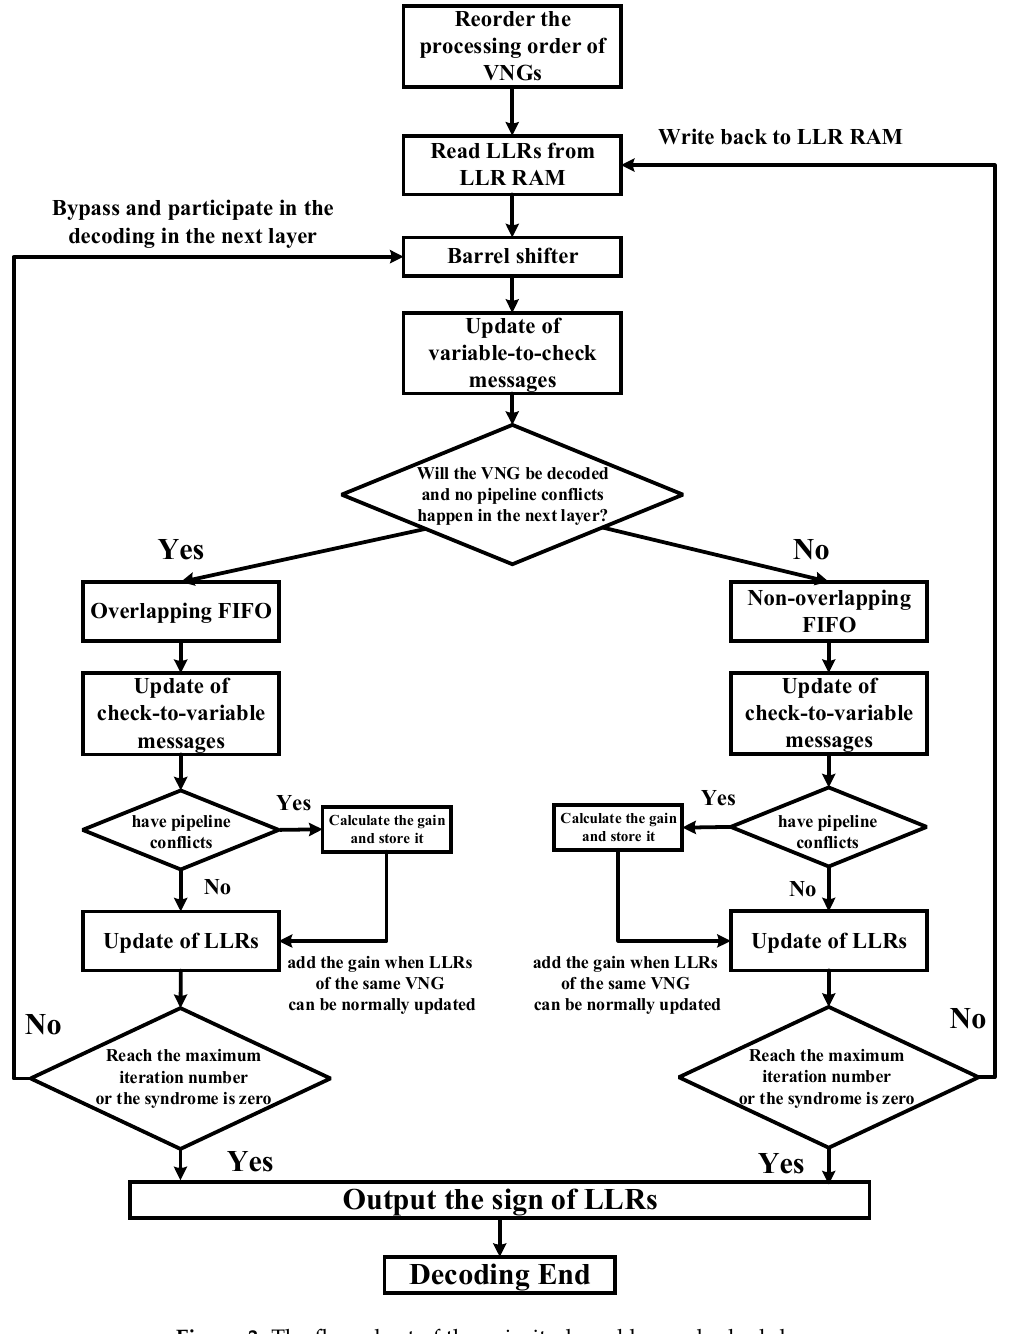
Figure 3. The flow chart of the priority-based layered schedule. In our design, variable nodes in a layer are processed in units of submatrix. For sim- plicity of presentation, the variable nodes in a submatrix are denoted as variable node group (VNG). Before decoding, the processing order of VNGs in a layer needs to be reor- dered. In a layer, the VNGs that have not been decoded in the previous layer are decoded first. Next are the VNGs that have been decoded in the previous layer. When the processing order of VNGs is determined, decoding starts. LLRs are suc- cessively read out from LLR RAM. After the processing of barrel shifter and VNU, varia- ble-to-check messages are obtained. According to the mechanism of double update queues, variable-to-check messages are buffered into overlapping FIFO or non-overlap- ping FIFO. Then, the check-to-variable messages are updated.